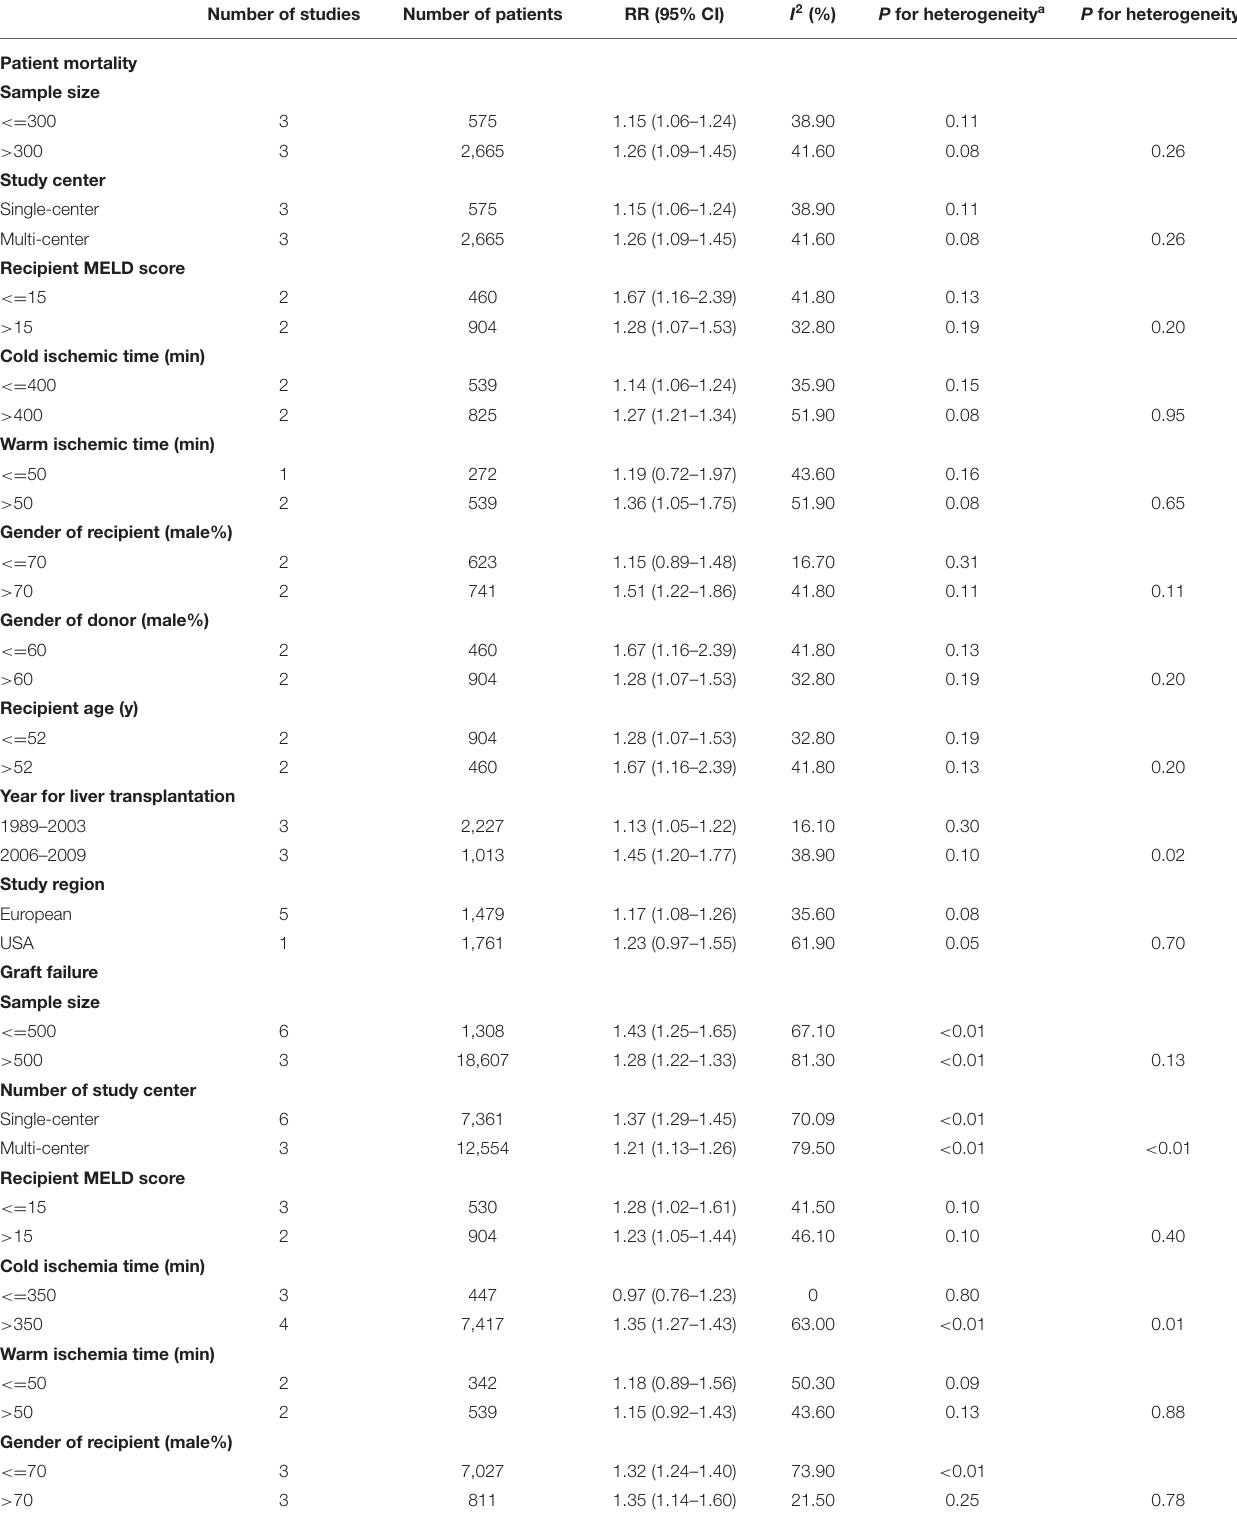
TABLE 5 | Subgroup analysis on dose-response risk of donor age on post-transplant outcomes. Number of studies Number of patients RR (95% CI) I 2 (%) P for heterogeneity a P for heterogeneity b